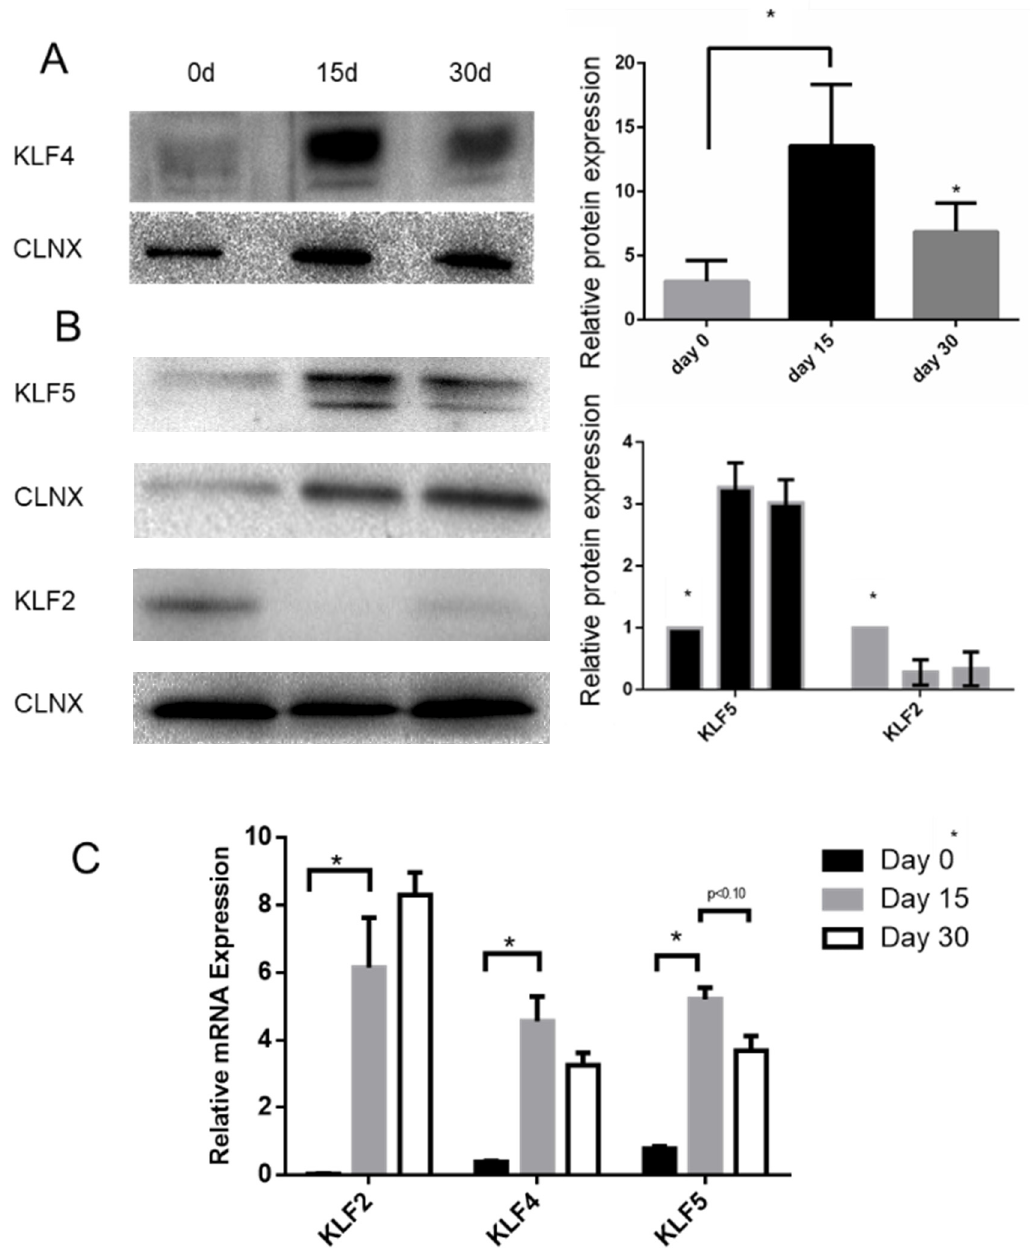
Figure 6. KLF2, KLF4, and KLF5 expression during BCi di ff erentiation. KLF4 ( A ), KLF5, and KLF2 ( B ) expression during BCi di ff erentiation. Representative KLF4, KLF2, and KLF5 Western blot (WB) images are shown. Calnexin was used as loading control. Data is normalized to loading control and showed as relative expression (vs. day 0) ( B ) or as arbitrary units (A.U.; n = 3, unpaired t -test, * is p < 0.05). ( C ) mRNA levels of KLF2 , KLF4 , and KLF5 were assessed by qRT-PCR. Samples were retrieved during BCi di ff erentiation ( n = 3, unpaired t -test, * is p -value < 0.05).